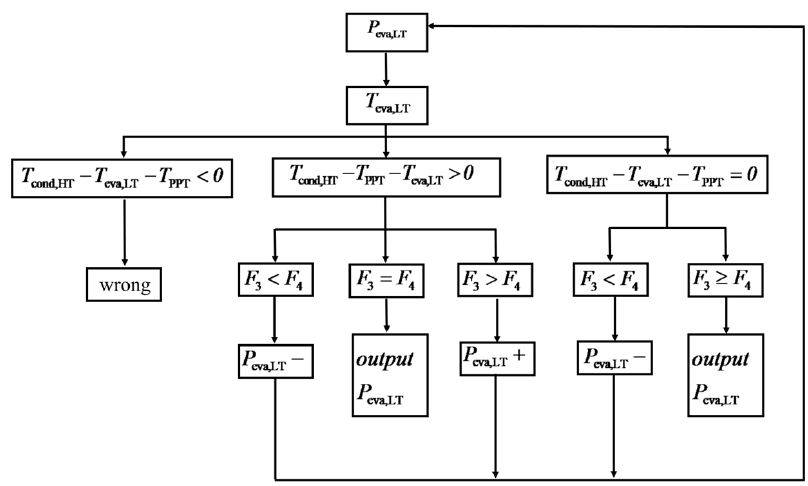
Figure 9. T-s diagram of the LT loop in case b. The calculation flow for P in case b is listed in Figure 10. eva ,LT The calculation flow for P eva,LT in case b is listed in Figure 10.